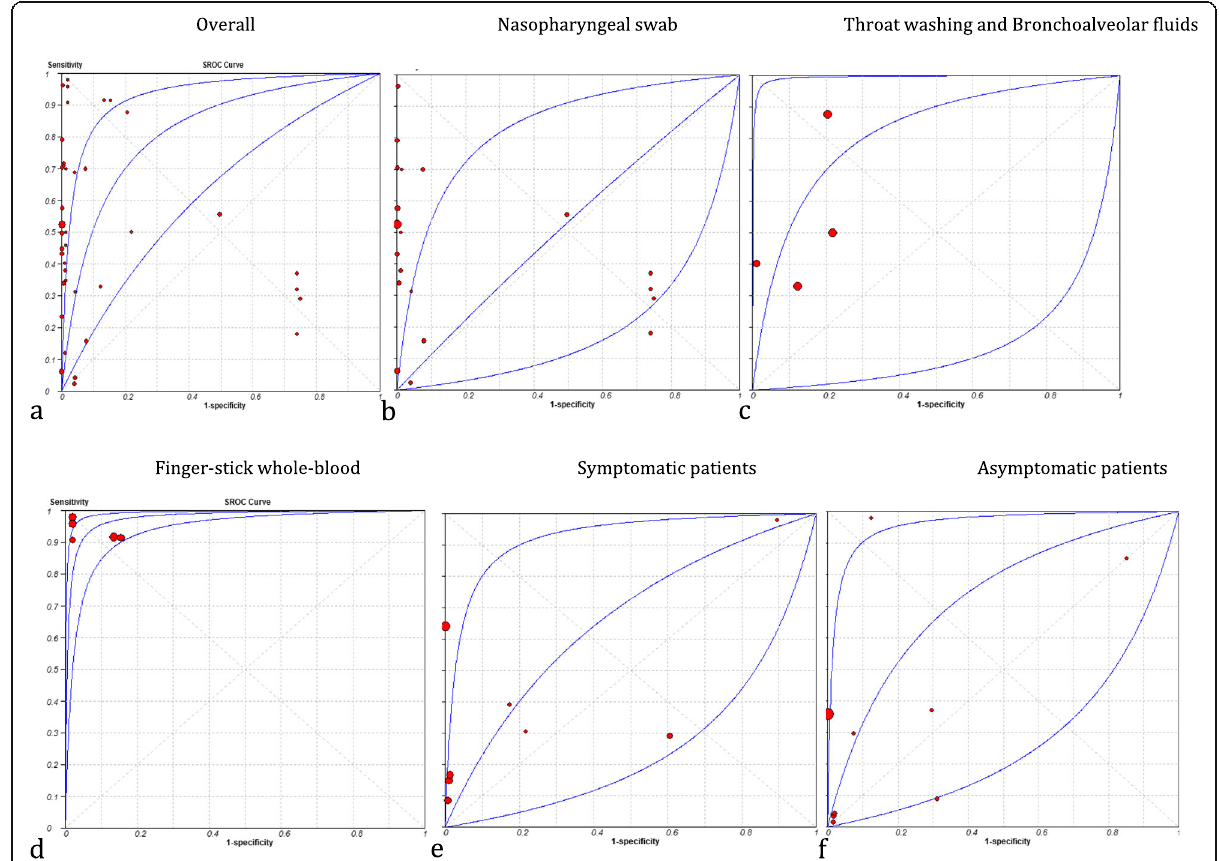
Fig. 2 Summary receiver operating characteristic curve (ROC curve). Estimates of sensitivity and specificity for each study